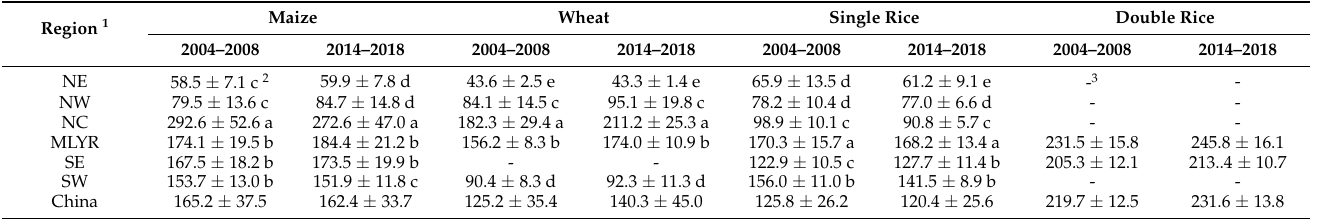
Table 3. Nitrogen losses of fertilizer (kg N ha − 1 ) for maize, wheat, single rice and double rice between the 2004–2008 and 2014–2018 at the region and national scale in China’s farmlands,